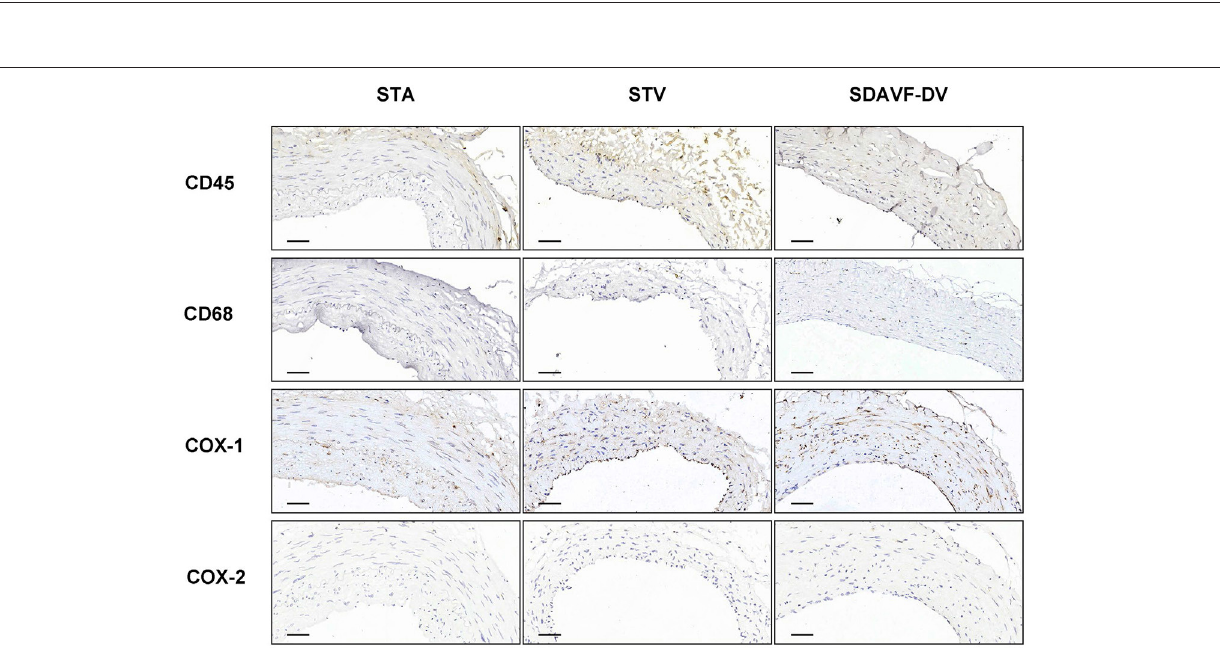
Frontiers in Neurology | www.frontiersin.org